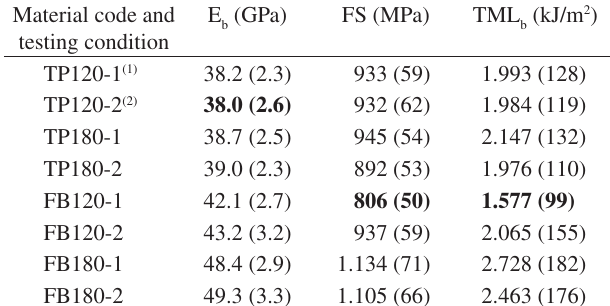
Table 2. Slow-bend test mean values at room temperature and two distinct loading rates. Standard deviation is provided in parenthesis. Material code